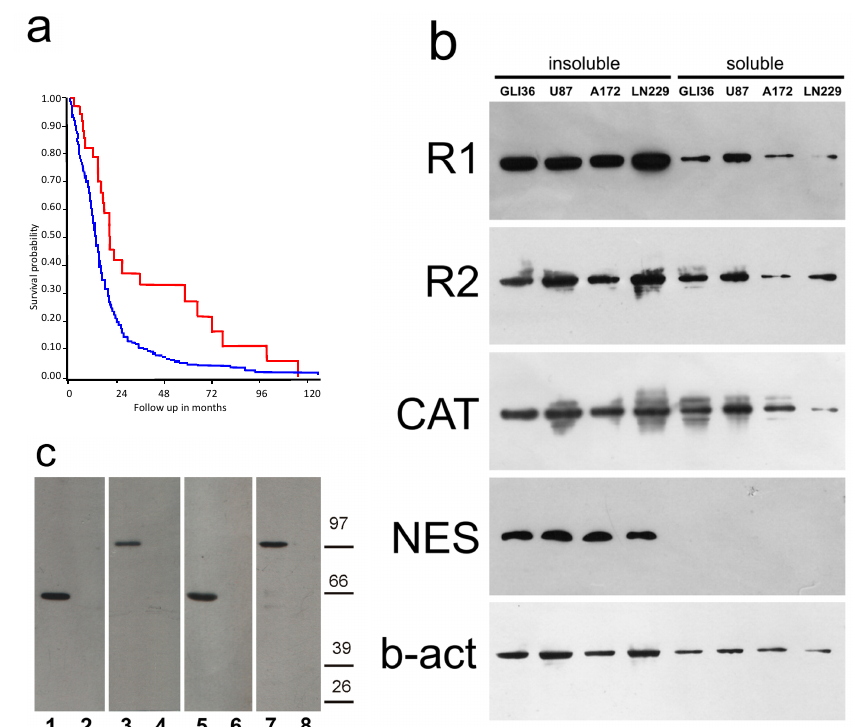
Figure 1. ( a ) Survival of glioblastoma multiforme (GBM) patients, clustered according to PKAR2A gene expression. Data from the the Cancer Genome Atlas (TCGA) database. Patients showing the highest PKAR2A gene expression ( n = 469) had lower survival (lower blue line), as compared to patients showing a lower expression (highest red line, n = 35). ( b ) Western blot on insoluble (first four lanes) and soluble (four lanes to the right) fractions of Gli36, U87, A172, and LN229 human glioblastoma cells. From the top, they were reacted with anti-R1, R2, cAMP-dependent protein kinase (PKA) catalytic subunit (CAT), nestin (NES), and beta-actin (b-act). R1, R2, and catalytic subunits were present in both soluble and insoluble fractions. All cell lines were nestin-positive. ( c ) Western blot on insoluble (lanes 1, 3) and soluble (lanes 2, 4) fractions of human glioblastoma biopsy (case 6), and on insoluble (lanes 5, 7) and soluble (lanes 6, 8) fractions of the primary culture derived from the same biopsy, reacted with anti-R2 (lanes 1, 2, 5, 6) and CD133 (lanes 3, 4, 7, 8). Molecular weight markers are indicated on the right. R2 was present the insoluble fractions of both the biopsy and primary culture derived from it. The samples were CD133-positive.